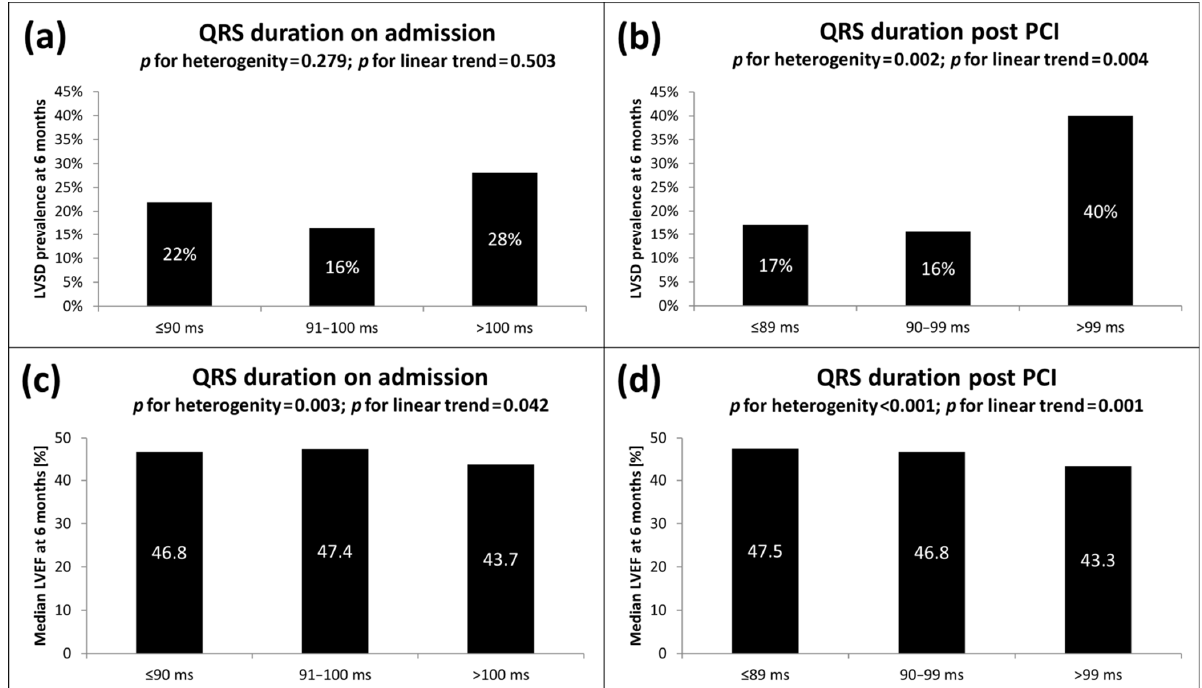
Figure 1. LVSD prevalence 6 months after STEMI according to terciles of QRS duration ( a ) on admission and ( b ) post PCI. Median LVEF 6 months after STEMI according to increasing terciles of QRS duration ( c ) on admission and ( d ) post PCI. LVEF, left ventricular ejection fraction; LVSD, left ventricular systolic dysfunction; ms, milliseconds; PCI, percutaneous coronary intervention; STEMI, ST-segment elevation myocardial infarction.